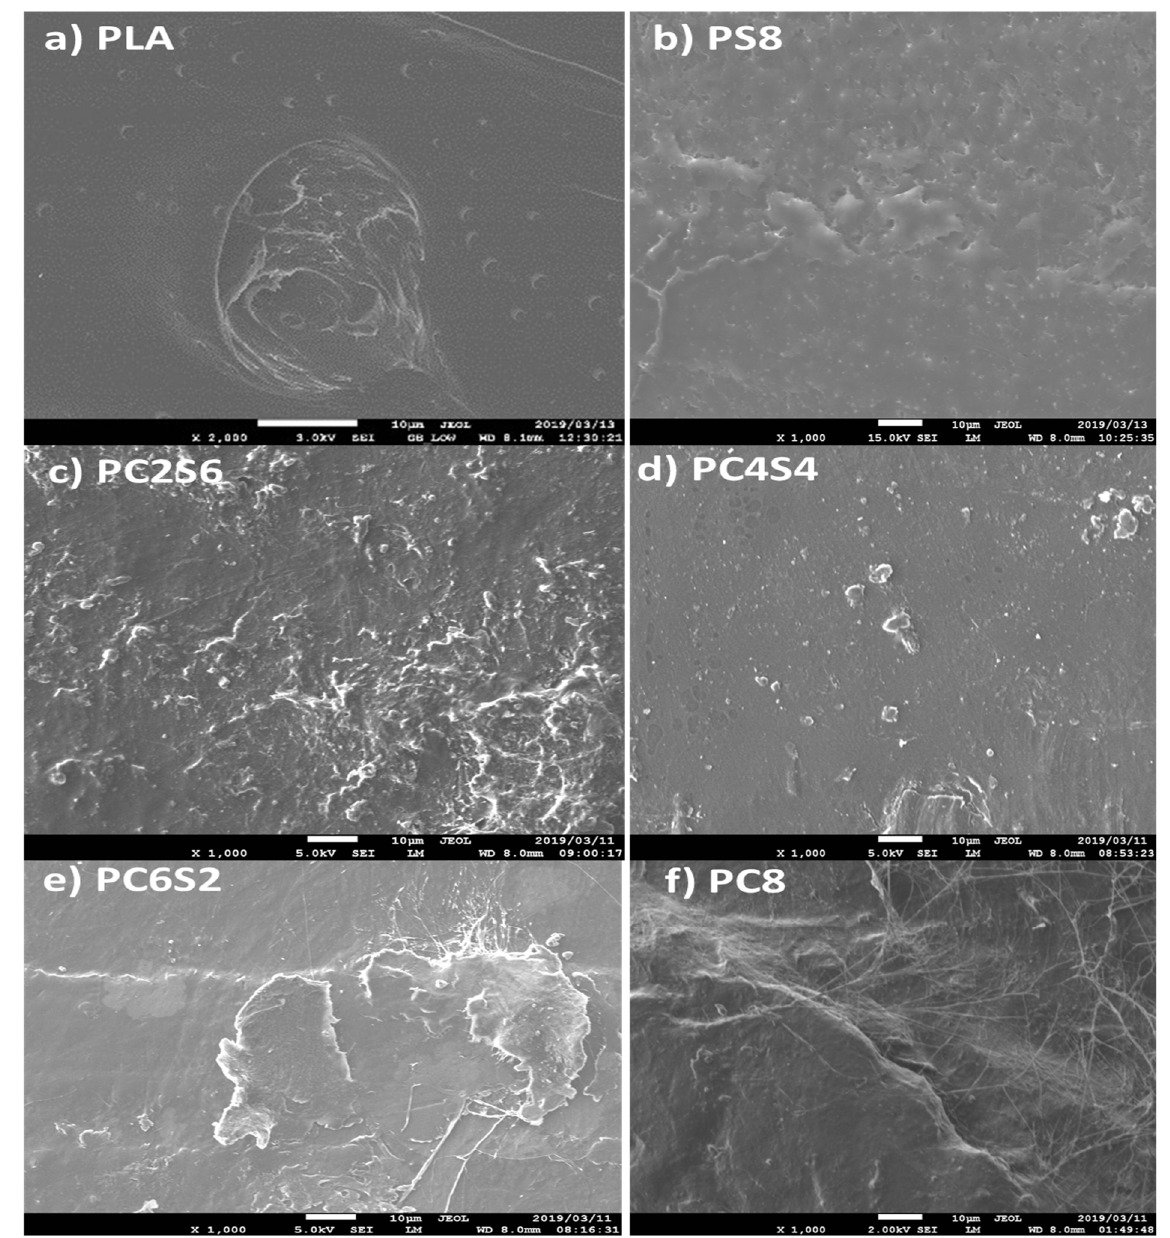
Figure 10. Tensile fractured surface scanning electron microscopy of the biocomposite.